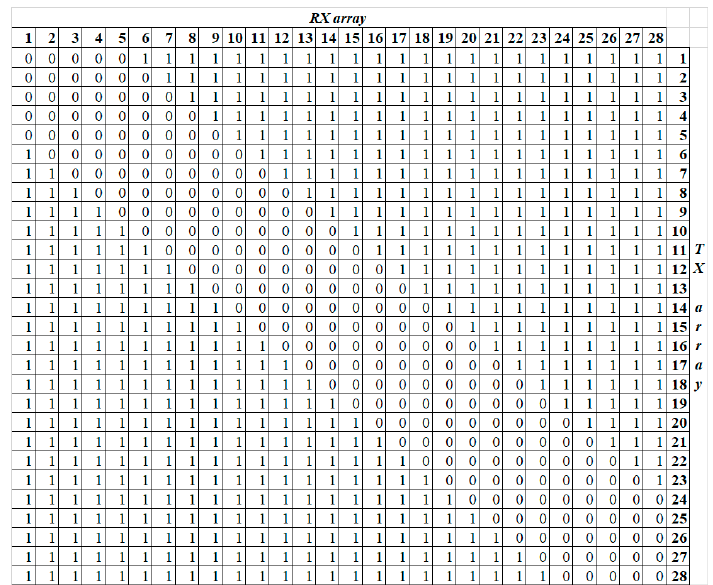
Figure 4. Transmit/receive apodization